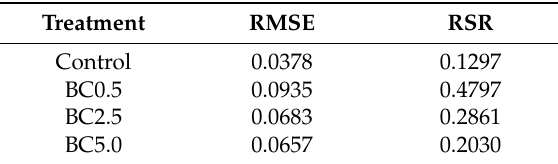
Table 2. Model performance statistics for soil water changes (SWC) changes for the different treatments. RMSE refers to root square mean error and RSR stands for standard deviation ratio.